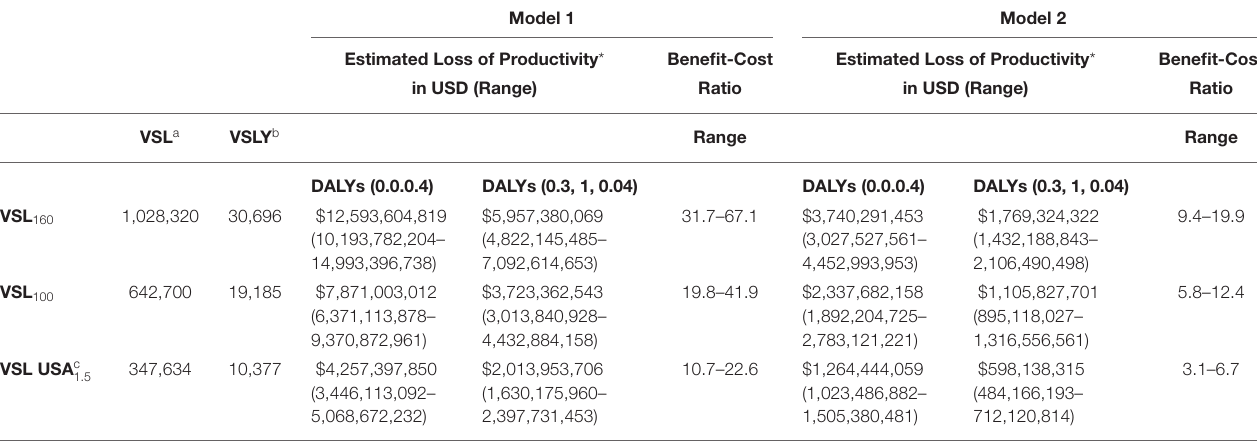
TABLE 6 | Estimated lost economic productivity—value of statistical life method. Model 1 Estimated Loss of Productivity * in USD (Range) Ratio in USD (Range) Ratio VSL a VSLY b Range Range DALYs (0.0.0.4) DALYs (0.3, 1, 0.04) DALYs (0.0.0.4) DALYs (0.3, 1,